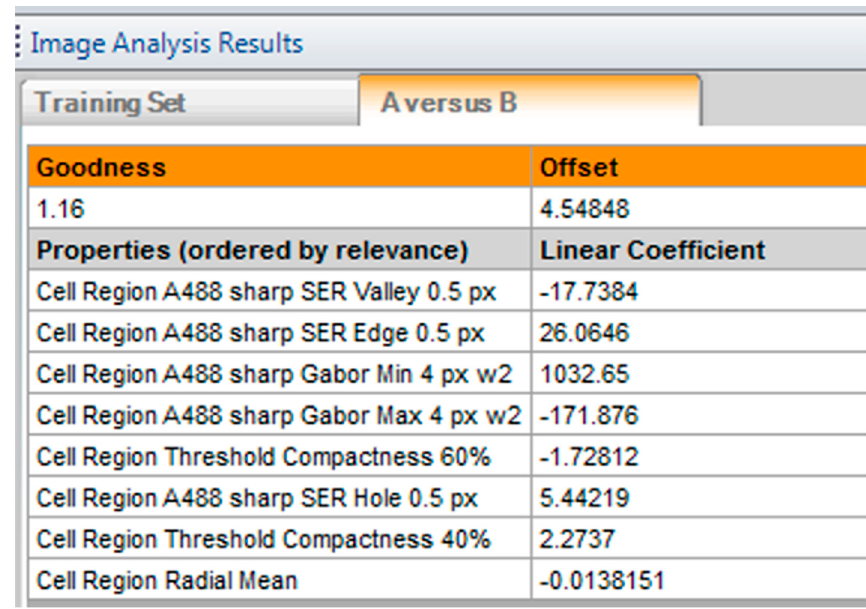
Figure A3. Parameters for machine learning step in the sarcomeric disarray analysis sequence. The PhenoLOGIC™ training relies on manual assignment of cardiomyocytes to two different categories (A, organised; B, disarrayed). The parameters of algorithm using the training set provided by the user indicate goodness of fit factor (>1) as well as the texture/ morphological properties evaluated by the software that differ the most between the two categories.